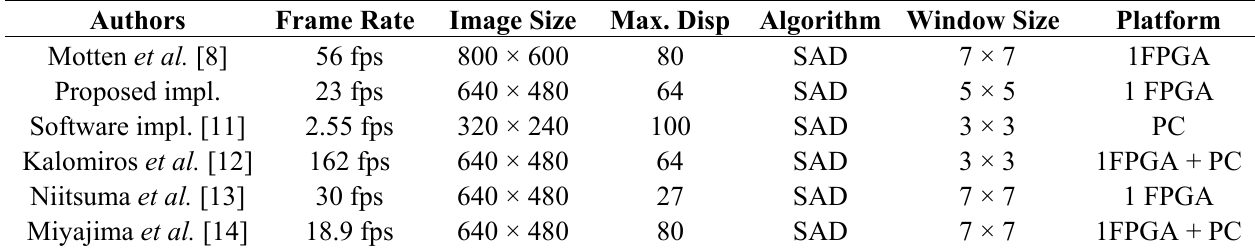
Table 4. Comparison of Stereo Matching